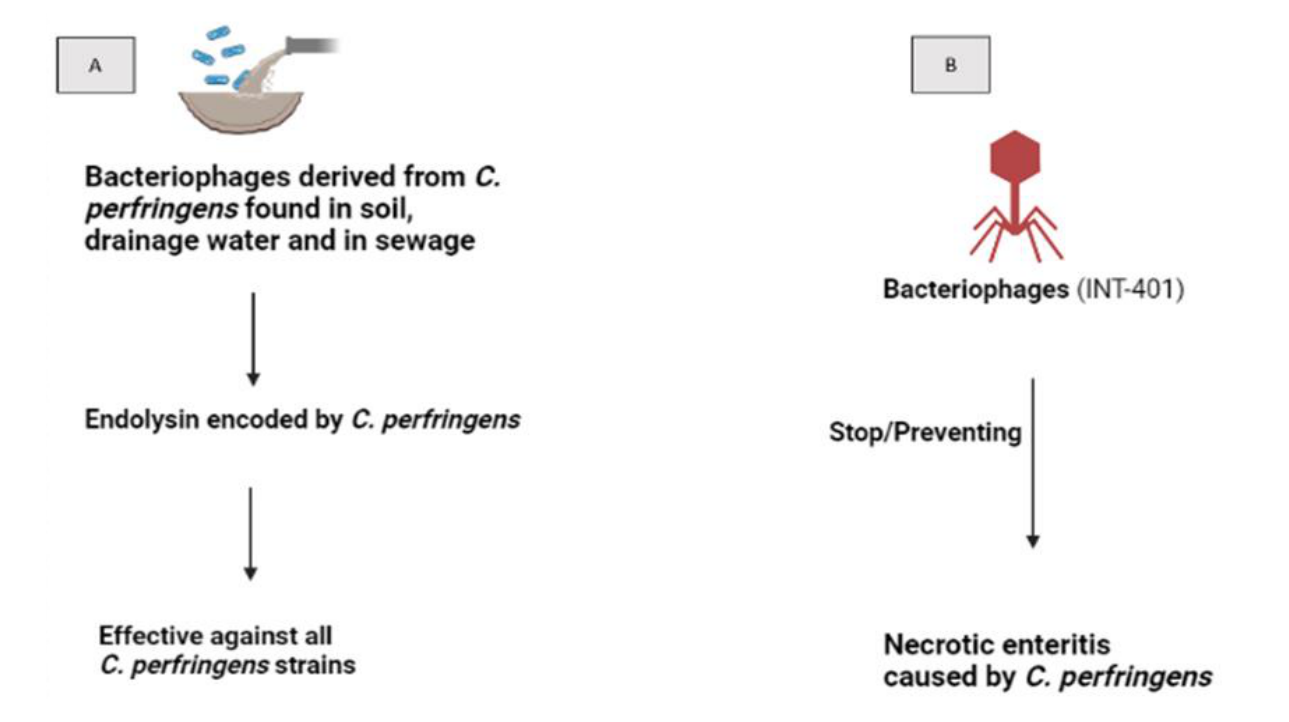
Figure 3. ( A ) C. perfringens bacteriophages found in soil, drainage water, and in sewage. Phages produced endolysin which causes cell breakdown and release the newly formed virions. Effective against all C. perfringens . ( B ) It has also been reported that bacteriophages (INT-401) prevent necrotic enteritis caused by C. perfringens .